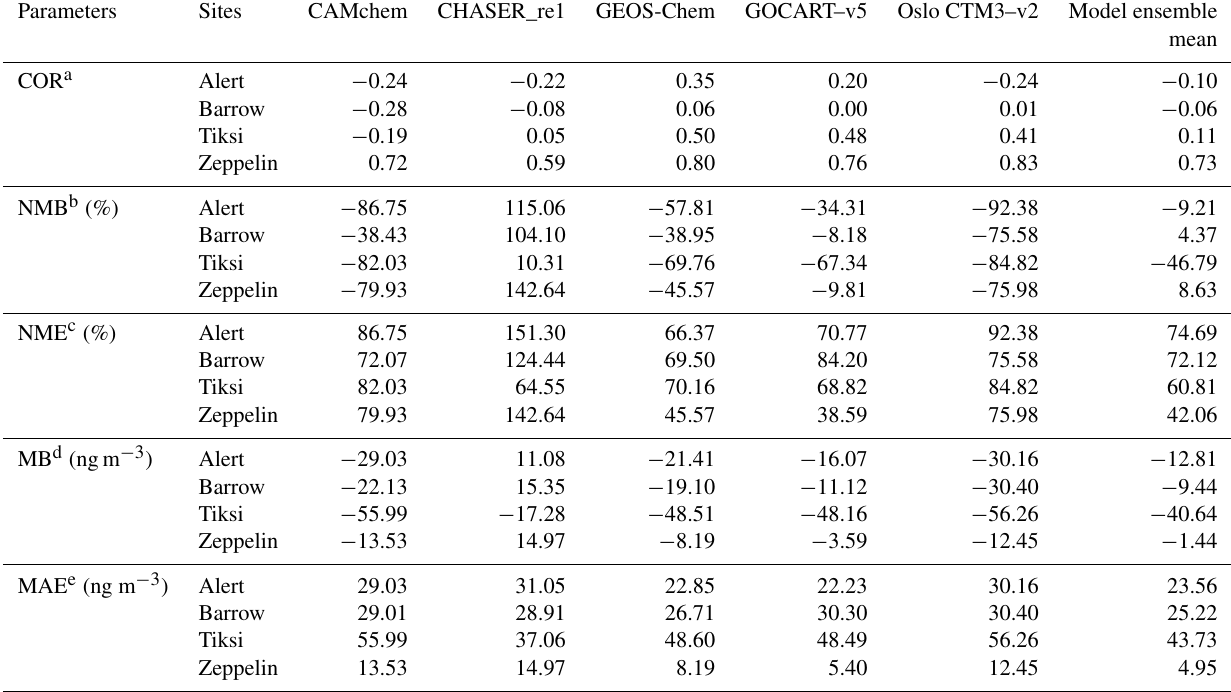
Table 3. Comparison of the simulations and observations of monthly surface BC concentrations at Alert, Barrow, Tiksi, and Zeppelin in 2010.